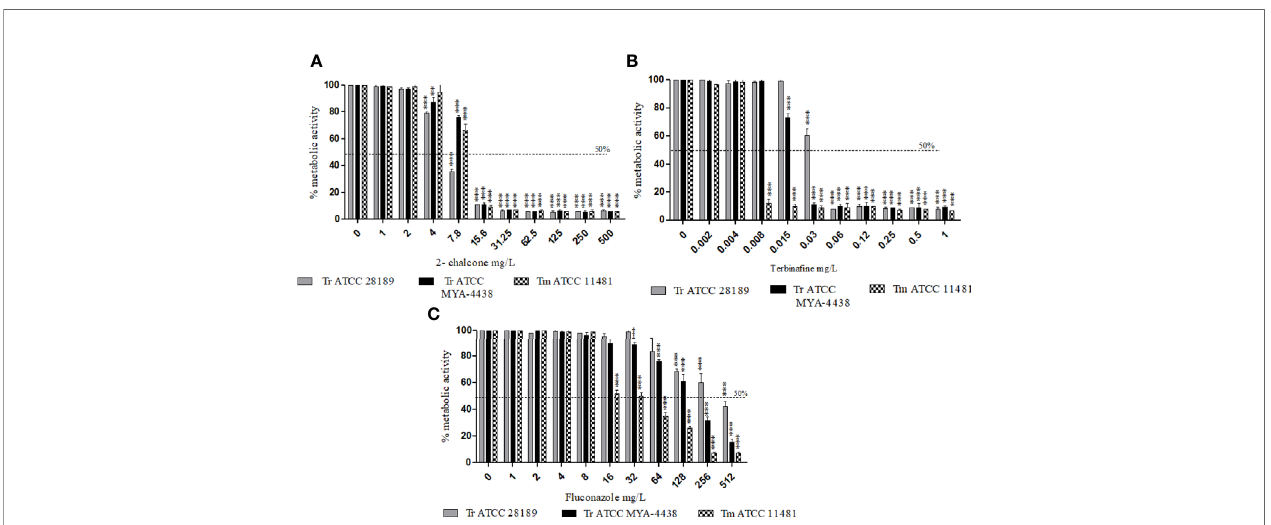
FIGURE 1 | Effect of 2-chalcone (A) , terbina fi ne (B) , and fl uconazole (C) on early-stage bio fi lms of T. rubrum ATCC 28189, T. rubrum ATCC MYA-4438, and T. mentagrophytes ATCC 11481 measured using the XTT reduction assay. The compounds 2-chalcone and terbina fi ne inhibited the metabolic activity of early-stage bio fi lms from the concentrations of 15.6 and 32 mg/L in all strains tested. Bio fi lms formed by both the T. rubrum strains conferred resistance to fl uconazole at all concentrations tested. Bio fi lms of the T. mentagrophytes strain were inhibited from the concentration of 64 mg/L (**p < 0.01; ***p < 0.001). Tr, T. rubrum ; Tm, T. mentagrophytes .